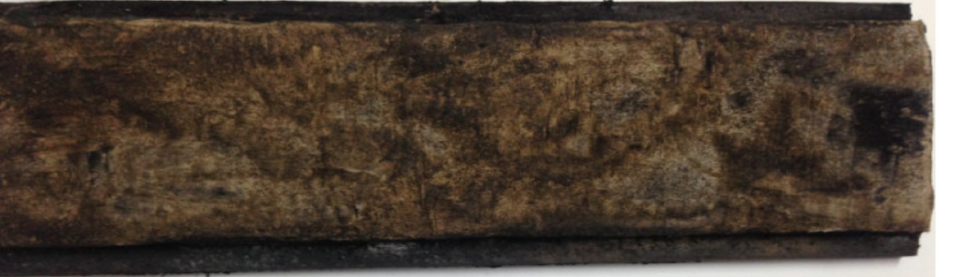
Figure 11. Surface state of insulation layer after second ablative experiment (gas phase velocity was 30